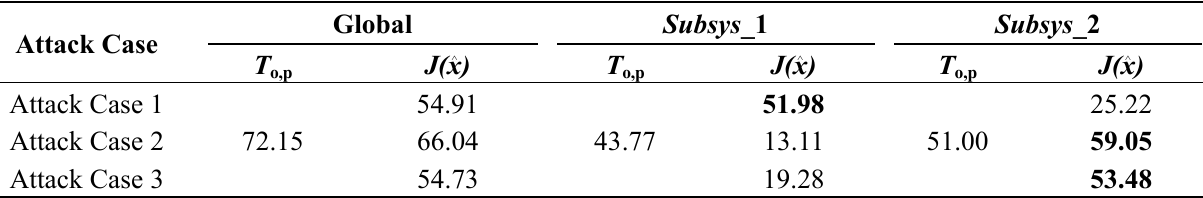
Table 6. Detection results on IEEE 14-bus system.